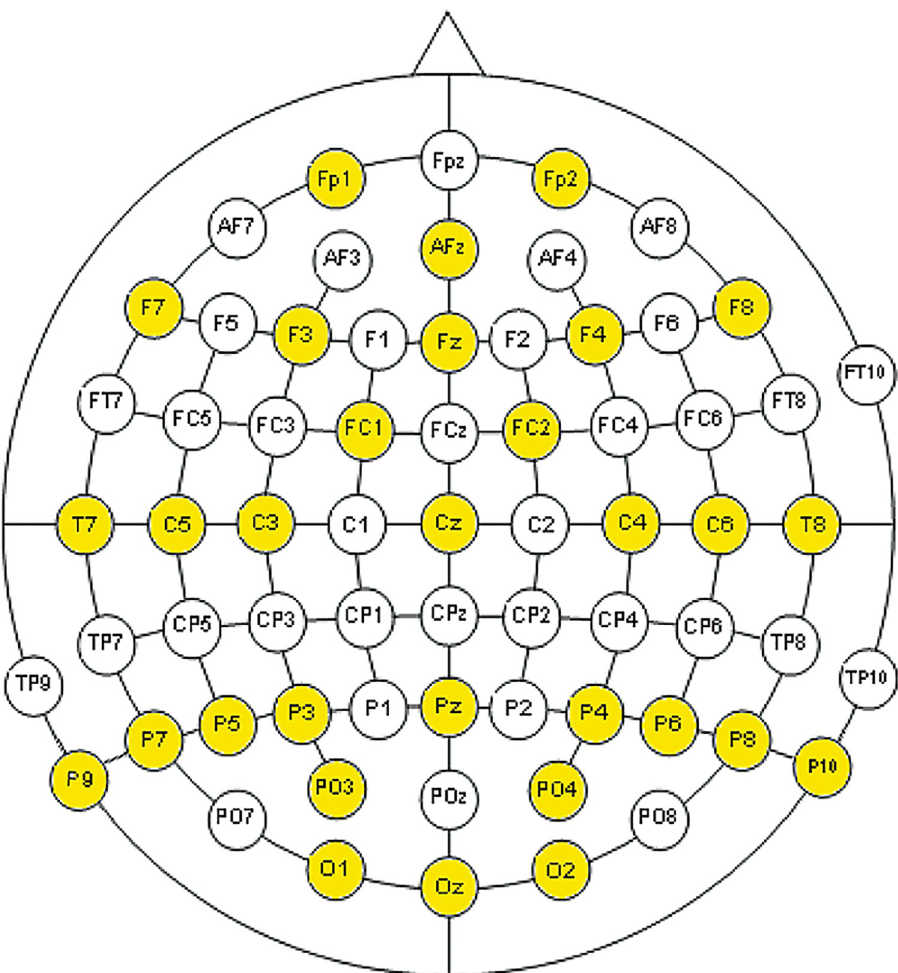
Fig 1. Distribution of the electrodes following the international 10–20 system for